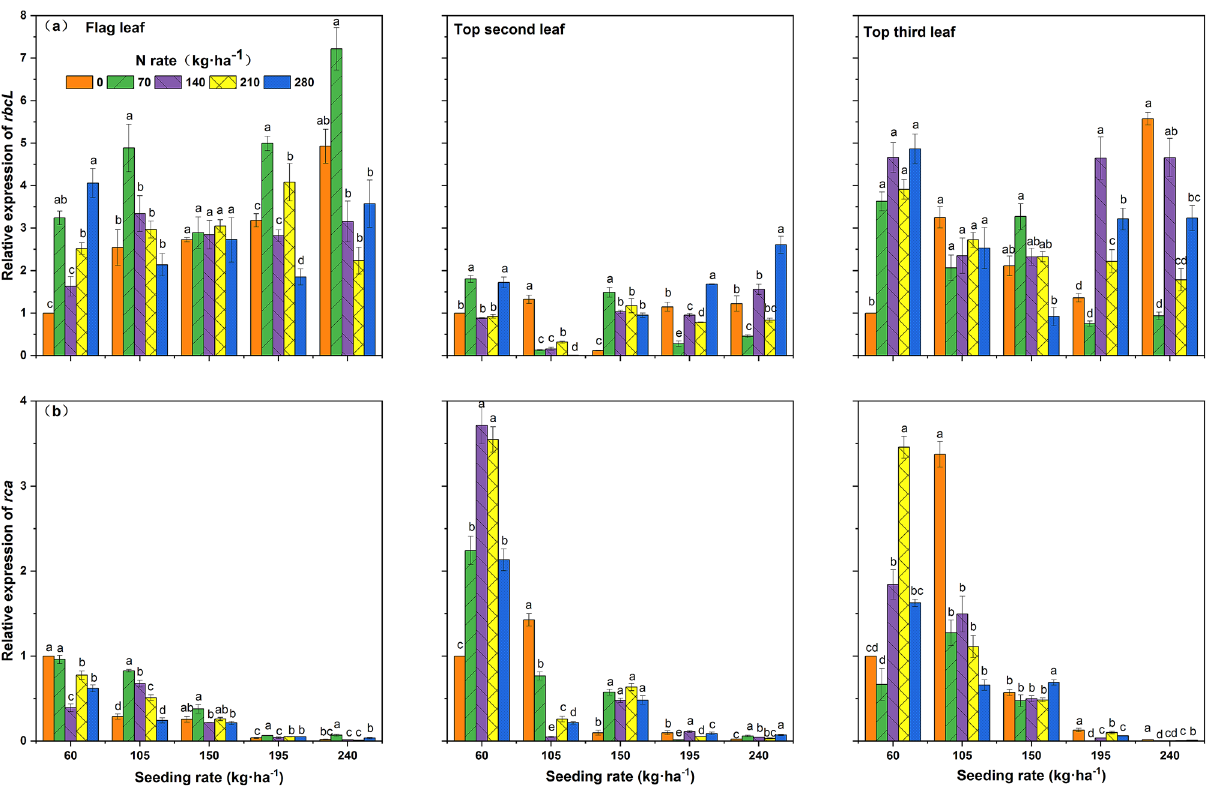
Figure 4. Effects of interaction between seeding rate and nitrogen rate on rbcL and rca gene expressions at different leaf positions of the rice population 10 days after flowering under dry cultivation. ( a ) The expression level of the rbcL gene in the flag leaf, the top two leaves, and the top three leaves. ( b ) The expression level of the rca gene in the flag leaf, the top two leaves, and the top three leaves. Different letters with the same sowing amount indicate a significant difference at P < 0.05. The figures were prepared and combined using Origin 2018 (www. origi nlab. com).